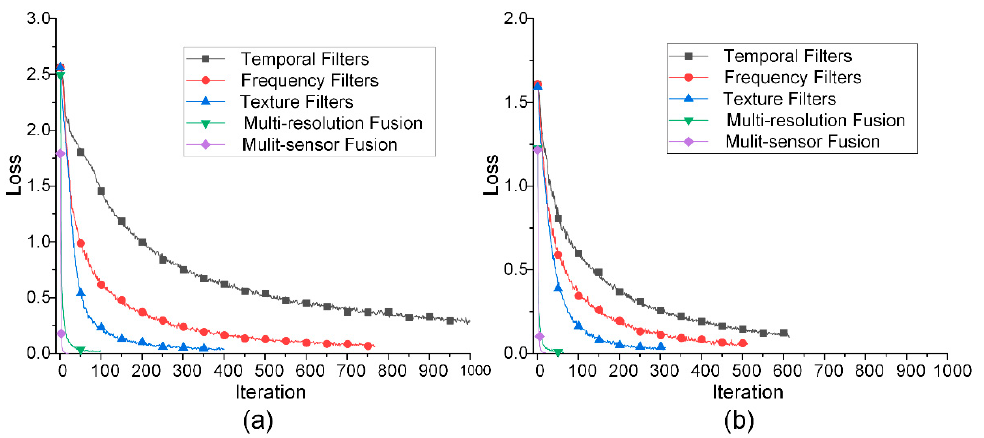
Figure 13. Loss curves of the three stages of the transfer learning: ( a ) The defect types and positions; ( b ) the defect types only.